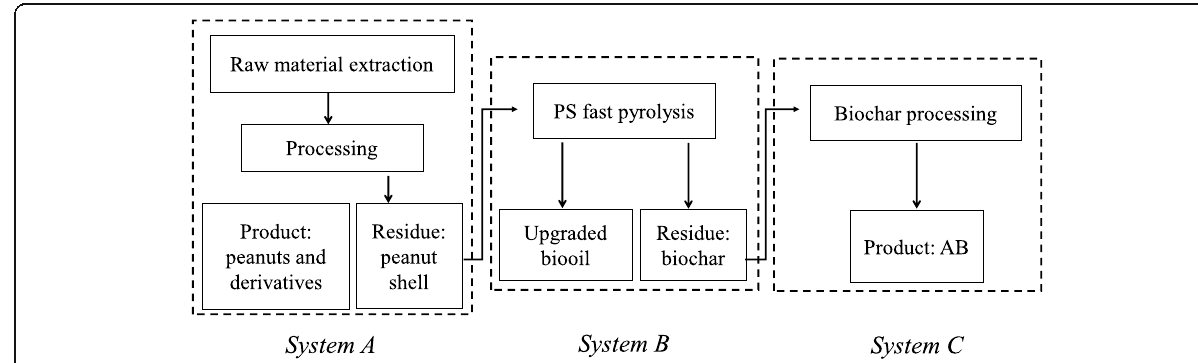
Fig. 1 Schematic illustration of open-loop recycling between three systems. “ Adapted from Journal of Cleaner Production, Vol 196, Johanna Olofsson and Pal Borjesson, Residual biomass as resource – Life-cycle environmental impact of wastes in circular resource systems,